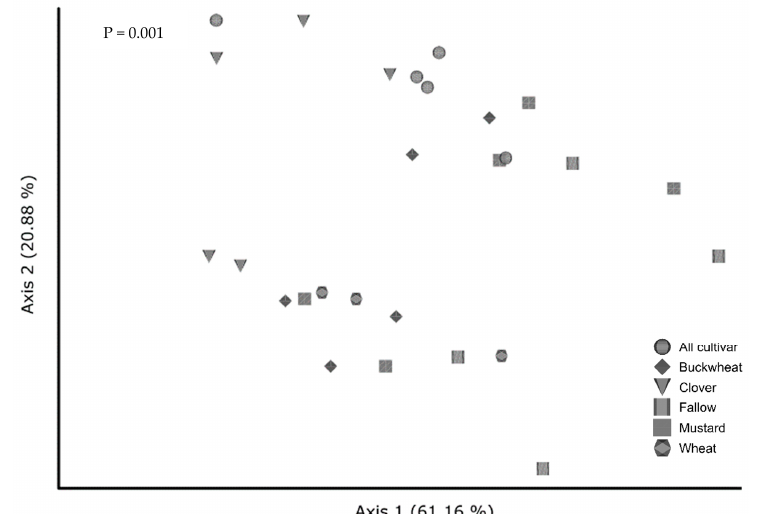
Figure 6. Principal coordinates analysis of fungal communities from cultivar cover crops visualized by Robust Aitchison distance. Treatments are all plants grown together (“All cultivar”), buckwheat (“buckwheat”), crimson clover (“Clover”), uninoculated fallow (“Fallow”), white mustard (“Mustard”), and wheatgrass (“Wheat”)m with the following significant pairwise interactions: All cultivar and Fallow ( p = 0.005, q = 0.045), All cultivar and wheatgrass ( p = 0.017, q = 0.084), Clover and Fallow ( p = 0.006, q = 0.045), clover and mustard ( p = 0.025, q = 0.084), clover and wheatgrass ( p = 0.037, q = 0.092).